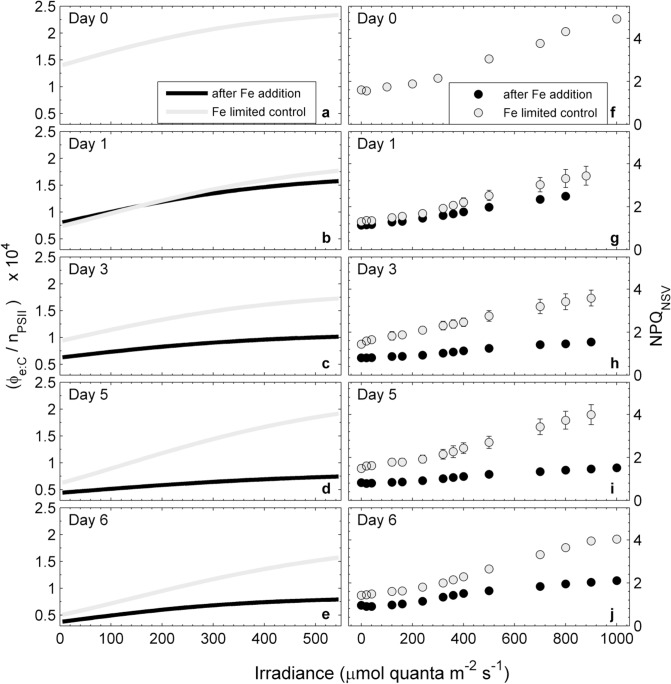
Changes in the light dependency of the conversion factor Φe:C/nPSII (a-e) and NPQNSV (f-j) over the course of the iron addition experiment.Units of in Φe:C/nPSII are (mol e- mol C) / (mol chl a mol RCII-1). The curves were derived by dividing corresponding values of ETRRCII and CO2-assimilation from the PvsE curves presented in Fig 3. NPQ was estimated as the normalized Stern-Volmer quenching coefficient NPQNSV = Fo′/Fv′ and is unitless [65]. Error bars are the standard error from three biological replicates and often smaller than symbols.